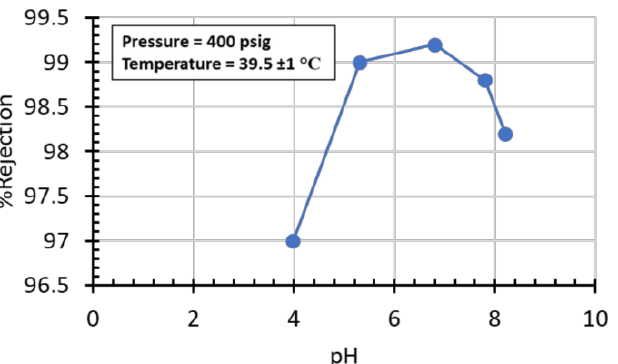
Figure 11. The %rejection reached a maximum between pH 5.31 and 7.8.